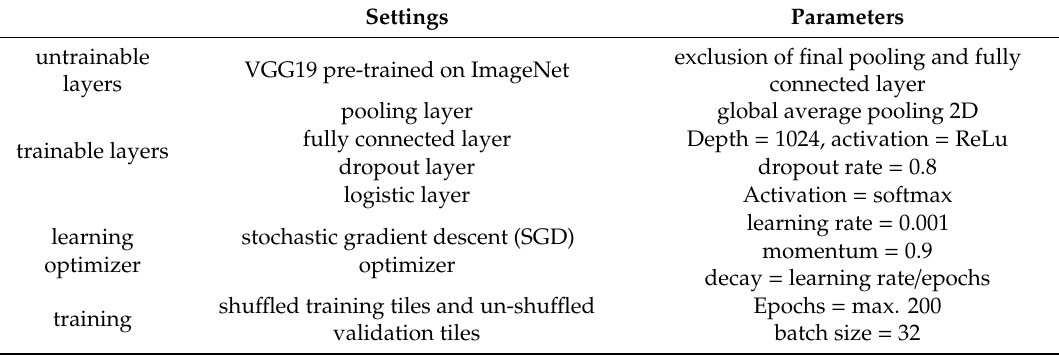
Table 3. Settings for our fine-tuned CNN based on Visual Geometry Group 19